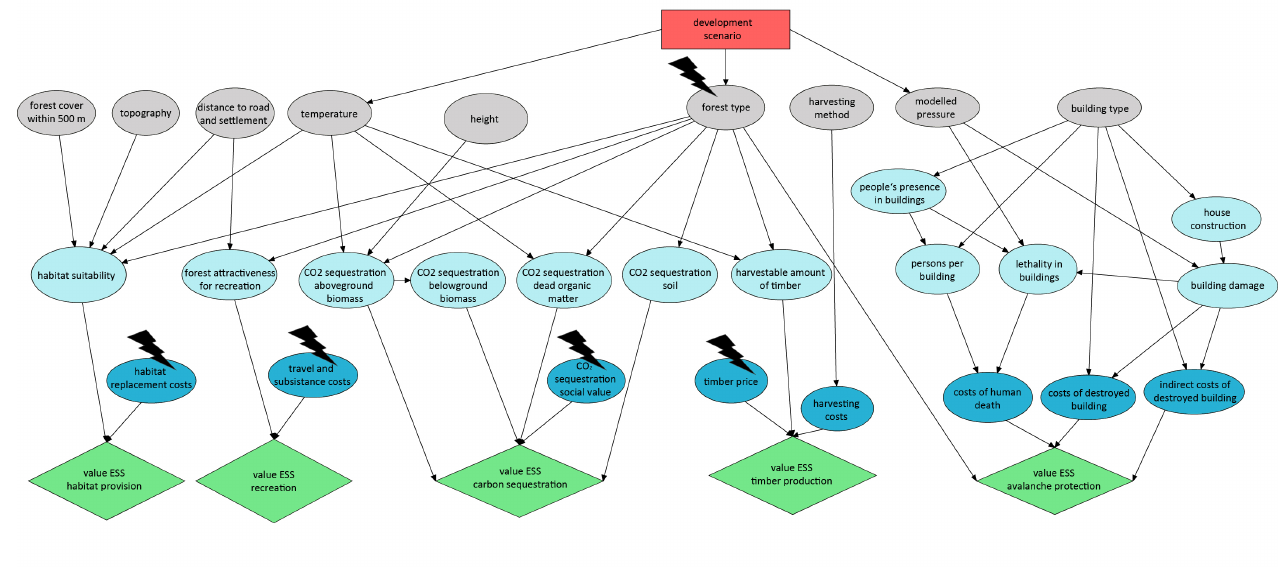
Fig. 3 . Bayesian network set up for the valuation of five forest ecosystem services (ESS). The grey nodes are spatially explicit input variables; the light and dark blue nodes are variables used to quantify and value the ESS; the red decision box on the top defines the land-use scenarios; the green nodes are the expected utilities in terms of changes in ESS values. Values of the variables in the nodes tagged with a black blizzard are updated by expert